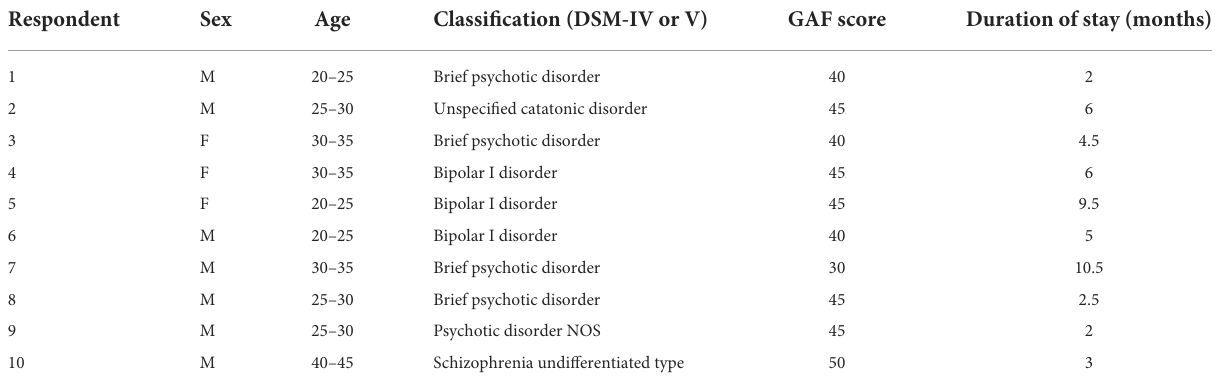
TABLE 1 Patient